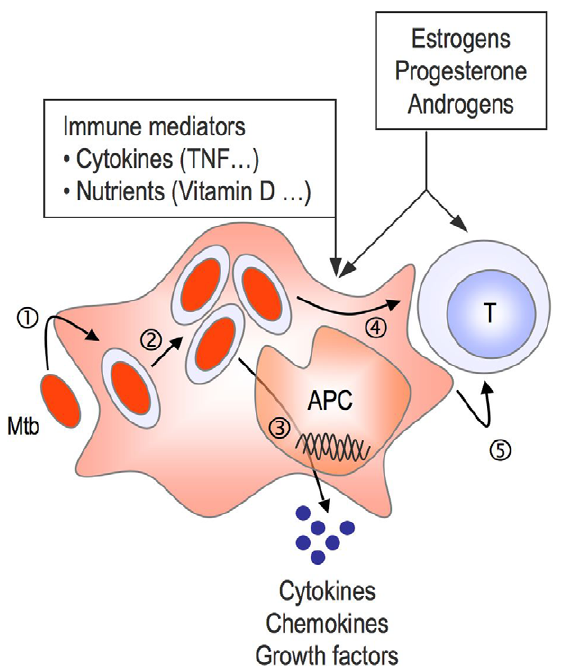
Figure 3. Do sex steroids influence antimycobacterial immunity? Both innate immune cells (monocytes, macrophages, and dendritic cells) and T cells express specific receptors for steroid hormones, at least a fraction of them [15]. Future experimental work may assess whether sexual hormones, alone or in combination with other immune mediators, influence M. tuberculosis (Mtb) entry (1) and intracellular trafficking and survival (2) in host phagocytes and antigen-presenting cells (APC), the secretion of cytokine and other factors by infected cells (3), antigen presentation (4), and T cell development (5).